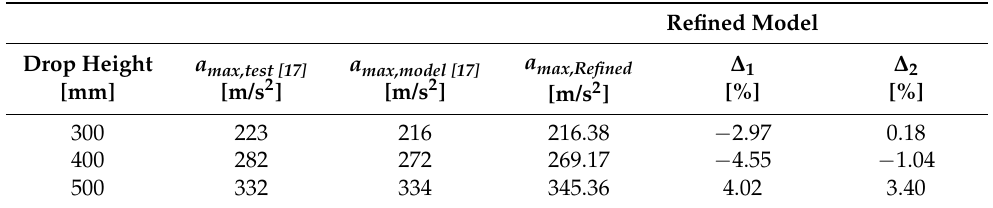
Figure 6. Numerical analysis of the Refined model (ABAQUS) under double twin-tyre impact (300 mm being the drop height), and comparison with the experimental results: ( a ) lateral displacement; ( b ) principal stress, and ( c ) acceleration time histories. Table 3. Summary of comparative results in terms of impactor acceleration for the present Refined numerical model and past experiments with a double